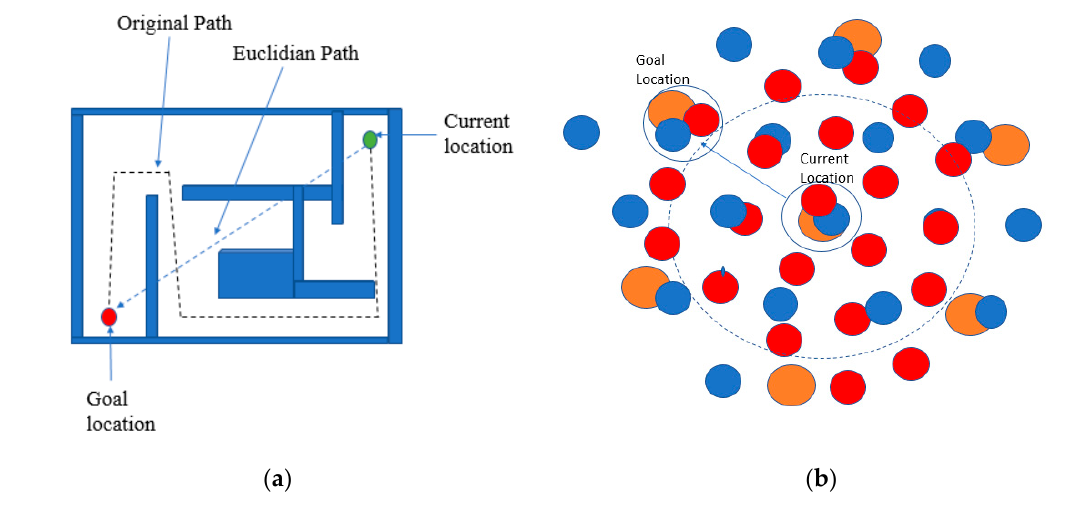
Figure 17. Illustration of agent navigation.